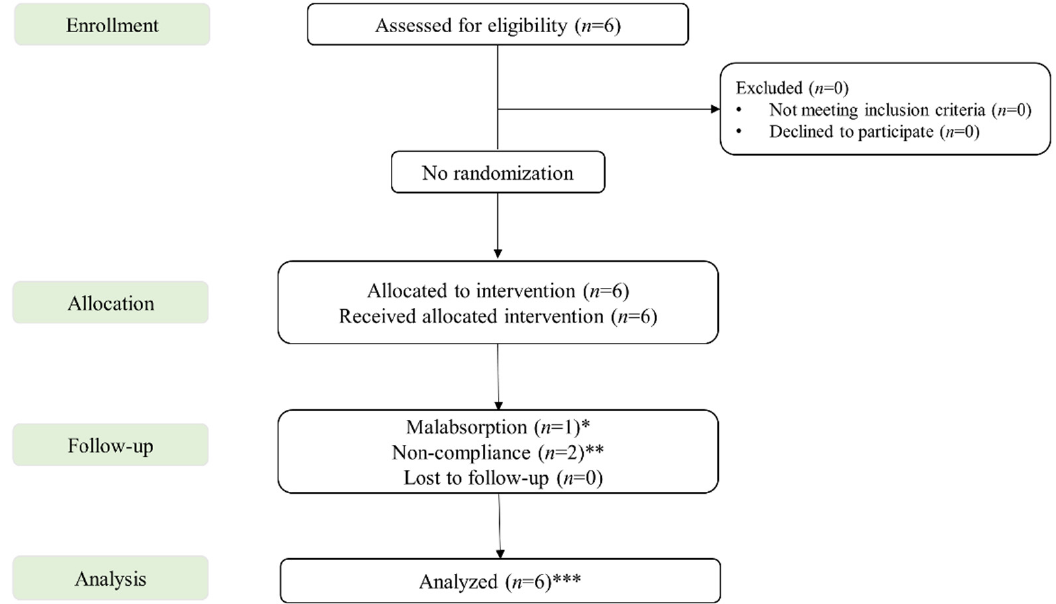
Figure 1. Flowchart for the single-case experimental study. * One patient developed daily, severe diarrhea after the first 1.5 years of the study, resulting in malabsorption of the supplement. ** In the case of two patients, vitamin E intake was irregular and inappropriate because of frequent hospitalizations. *** Data of all of the enrolled patients were analyzed.